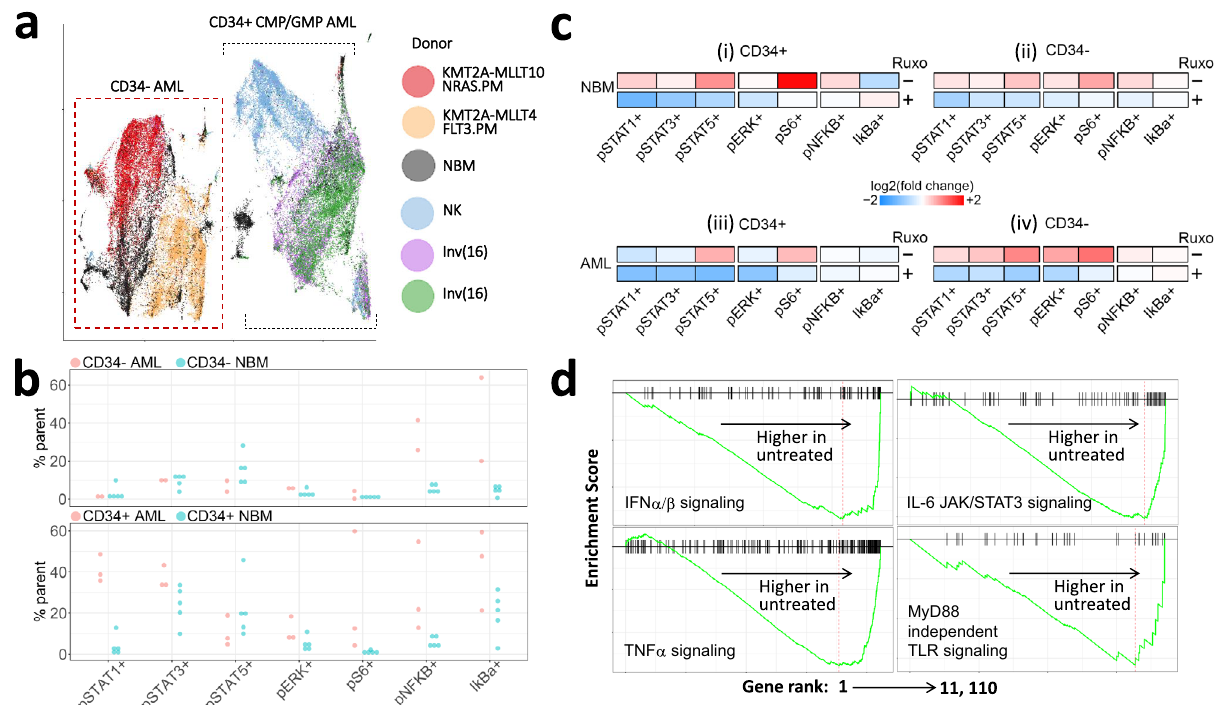
Fig. 4 | Phospho-CyTOF and RNA-seq suggest distinct cell-of-origin but com- mon receptor-mediated signaling in high-IL6/R pAML genomic subtypes. All plots show data from 5 high-IL6/R pAML samples. Panel A additionally includes 5 NBM as indicated. a UMAP projection of all CyTOF cell-type markers highlights clustering ofcellsfrom 2 samples with MLL(KMT2A ) fusions away from the cells of 2 samples with chromosome 16 inversion (Inv(16)) and 1 sample (blue markers) with Normal Karyotype (NK). MLL fusion partners and RAS/FLT3 muta- tion status of the samples are indicated in the color key. The phenotype of each AML cluster is indicated above the cluster. b Comparison of the basal signaling states of NBM and the same 5 high-IL6/R samples as in panel ( a ) in the absence of restingincytokine-richmediaorstimulationwithHS-5supernatant.Comparedto their counterparts in NBM, CD34+high-IL6/R pAML samples have higher fre- quencies of cells with activated (phosphorylated) STAT1 and STAT3, suggesting